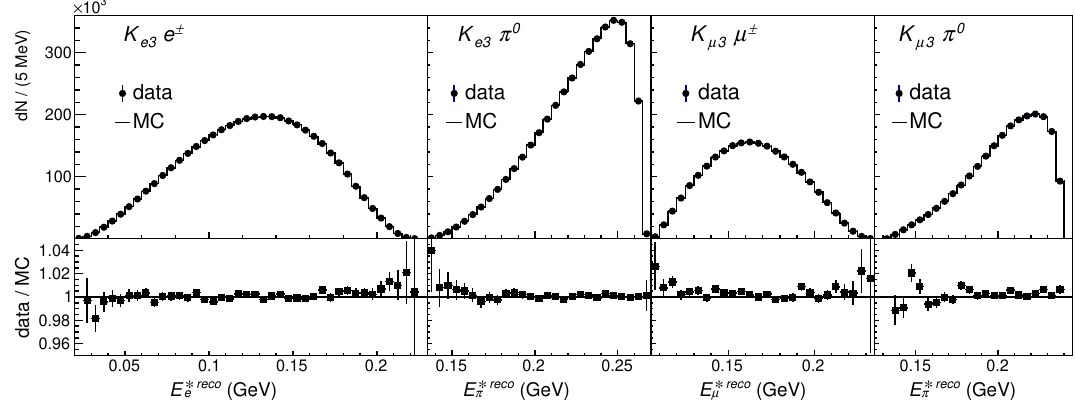
Figure 7 . Reconstructed lepton energy E (cid:3) reco K (cid:6) data (after background subtraction) and simulated samples according to the (cid:12)t results using the (cid:22) 3 Taylor expansion model, and corresponding Data/MC ratios. Simulated distributions according to (cid:12)t results using other parameterizations cannot be distinguished within the resolution of the